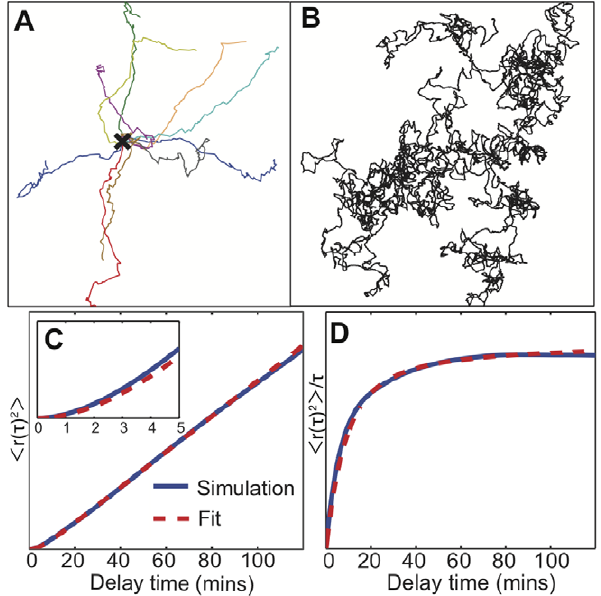
Figure 2. Simulated trajectories from the excitable cortex and memory (EC&M) model. A) An overlay of ten 10 minute segments of simulated paths, starting at the X in the center. The paths show persistence. The spatial scale is arbitrary and is set by the speed assigned to cells. B) A 200 hour-long simulated path. Over this much longer timescale the trajectory becomes diffusive. C) The mean squared displacement of the 200 hour path (blue), with a fit (dashed red) to the persistent random walk equation (see Methods). The persistence time from the fit is 4.0 minutes. D) The same mean squared displacement and fit plotted as S r 2 T (cid:4) t to highlight the crossover from ballistic to diffusive motion.